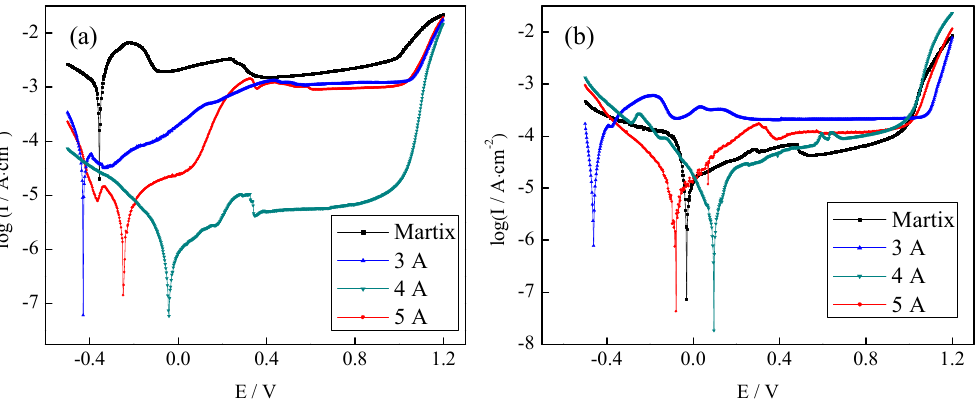
Figure 7. Potentiodynamic polarization curves of the CrN x coating in the working environment of the PEMFC bipolar plate (( a ) cathodic working environment, ( b ) anodic working environment). Figure 7b showed potentiodynamic polarization curves in the anodic working environment.